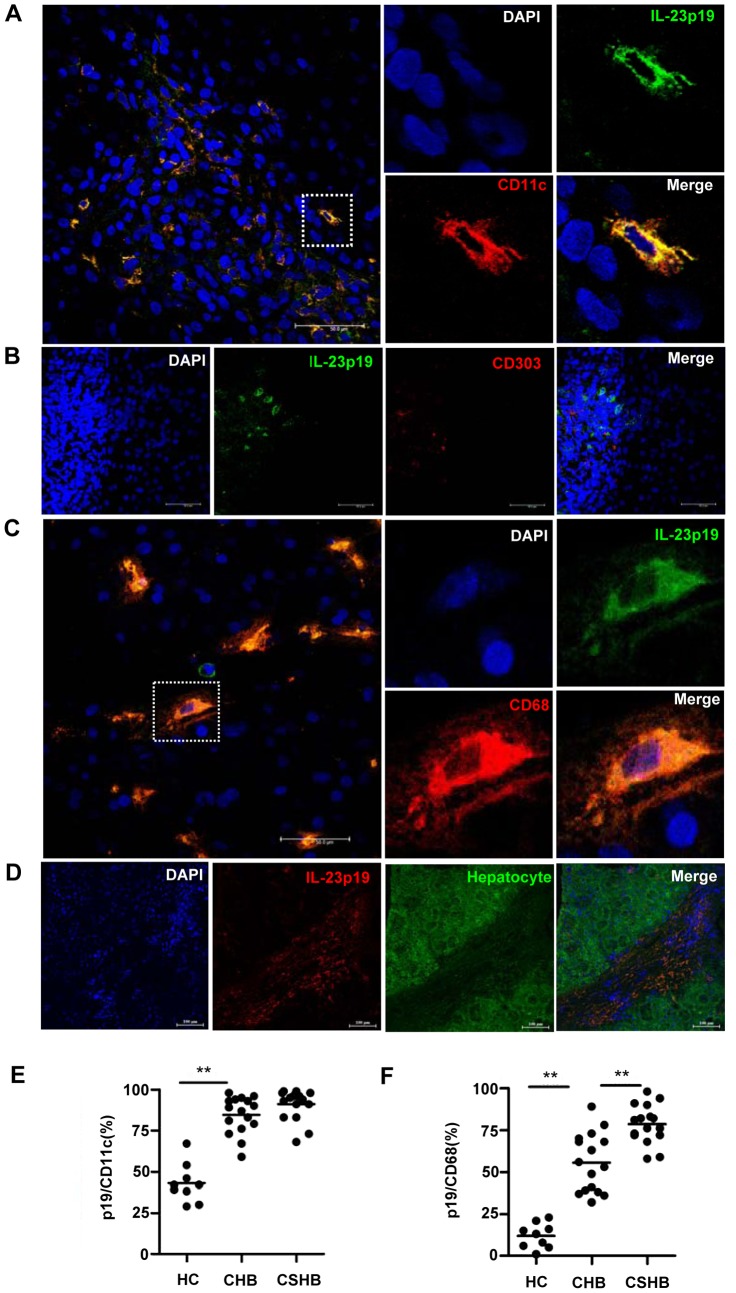
IL-23 is mainly derived from APCs in hepatitis B liver tissue.Co-localization (yellow) of IL-23 (p19, green) with mDC (CD11c, red) (A), pDC (CD303, red) (B), macrophage (CD68, red) (C), or IL-23 (p19, red) with hepatocyte (hepatocyte, green) (D) in CHB patients' liver tissues was detected by immunofluorescence staining. The right panels are enlarged images of the area in the left panel that is demarcated by a white dashed-line (A and C). (E and F), The frequencies of intrahepatic IL-23-positive mDCs or macrophages in the livers of patients with hepatitis B and healthy controls are shown. A total of 118 CD11c+ and 89 CD68+ cells were counted in 10 random fields (magnification 400×, 0.066 mm2) per section using a digital camera. Error bars indicate SD. **P<0.01.